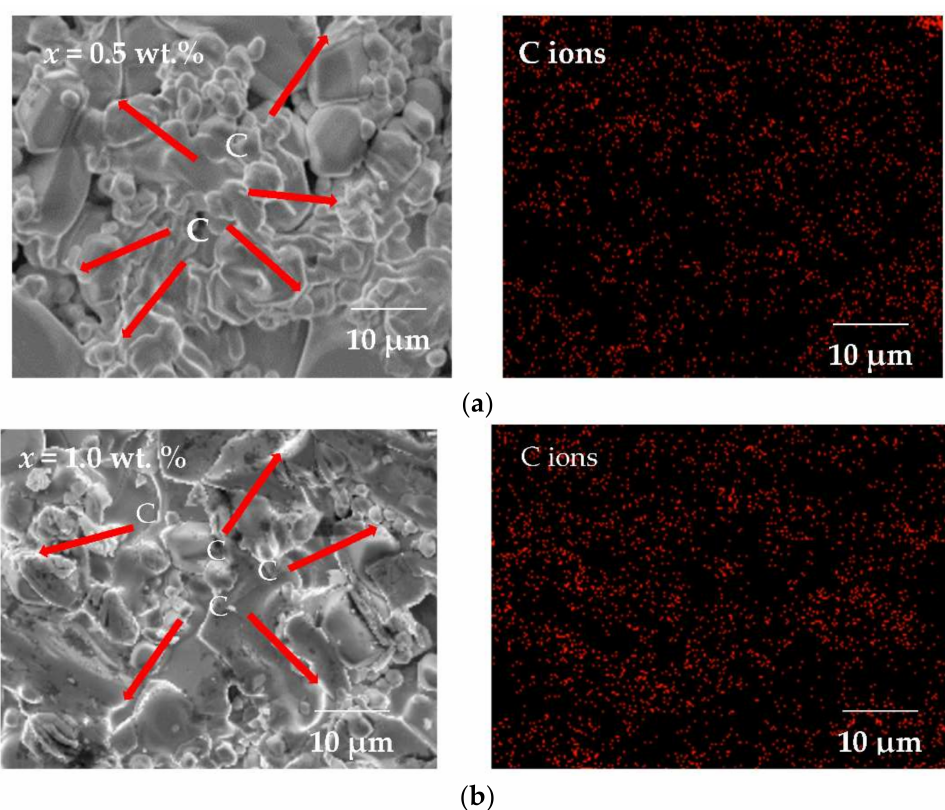
Figure 4. FESEM images and EDX mapping C ions (red dots) of the compound Y123 added with graphene nanoparticles up to ( a ) x = 0.5 wt.% and ( b ) 1.0 wt.%, indicating the presence of the expected elements.